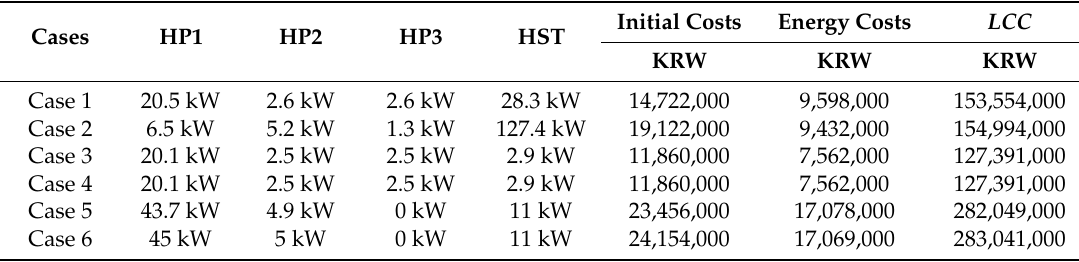
Table 8. The results of optimization